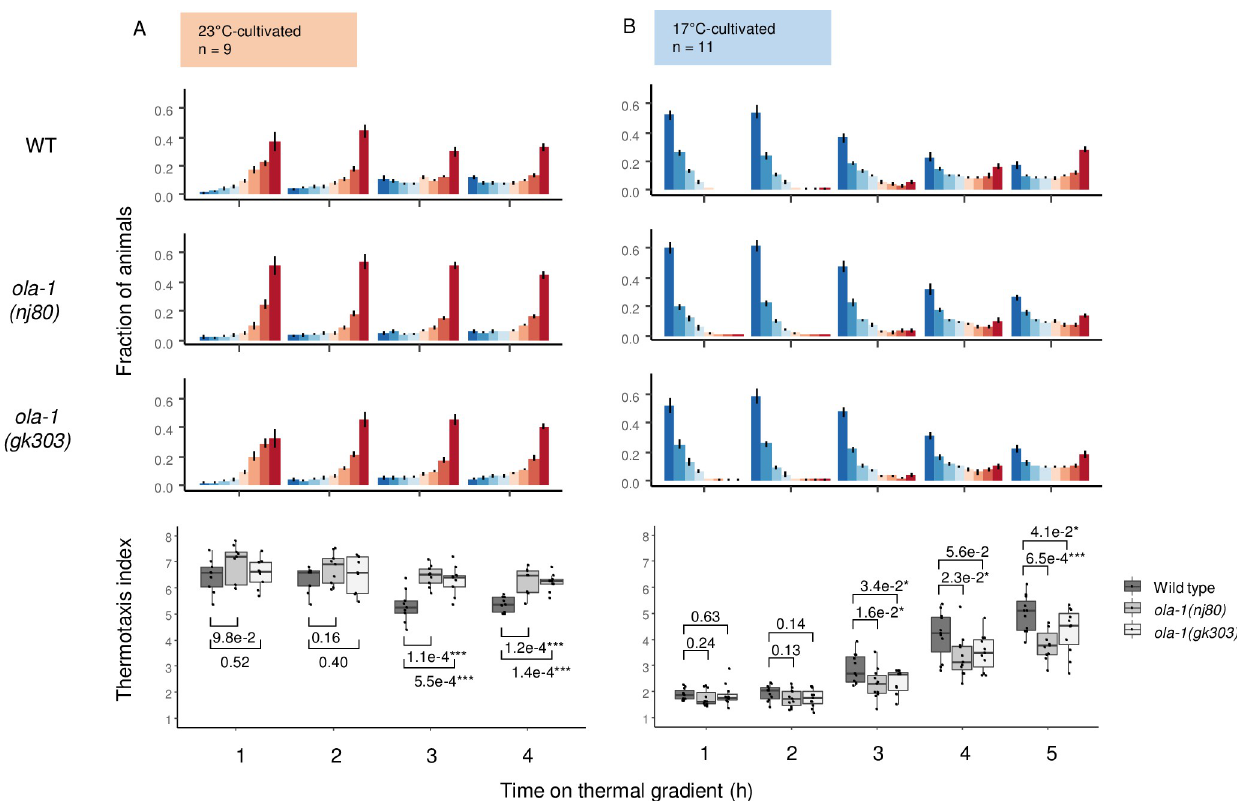
Fig 1. ola-1 mutants are slower in the transition of the thermotactic behavior. Wild type, ola-1(nj80) and ola-1(gk303) animals were cultivated at 23˚C for 3 days (A) or at 17˚C for 5 days (B) and allowed to freely migrate on a thermal gradient for the time indicated. Number of animals at each section of the plate was scored. Fraction of animals (upper) and thermotaxis indices (lower) are shown. p values were indicated (one-tailed Dunnett test against wild type animals at each time